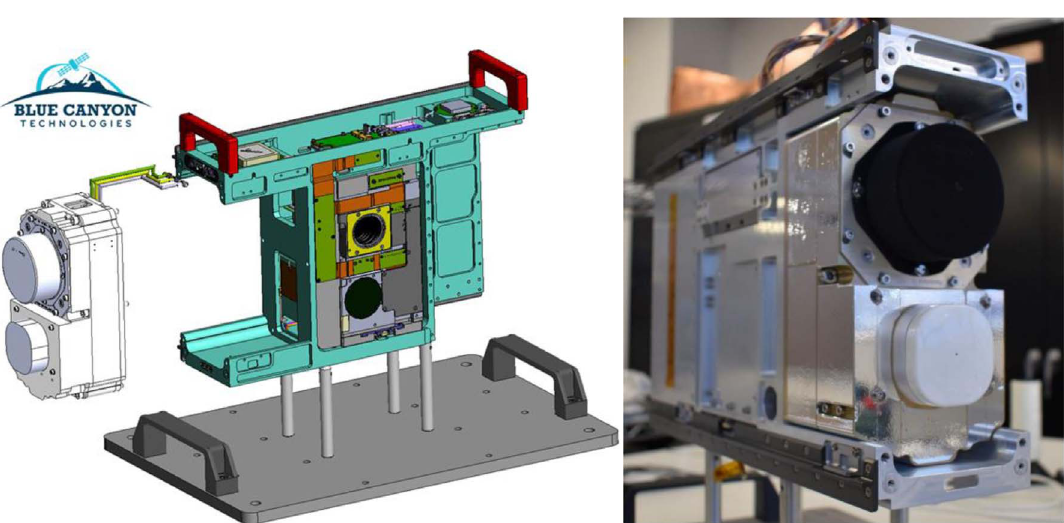
Fig. 4. CAD model (left panel), and photograph (right) showing how IRIS is integrated into the CIRCE bus chassis (courtesy Blue Canyon